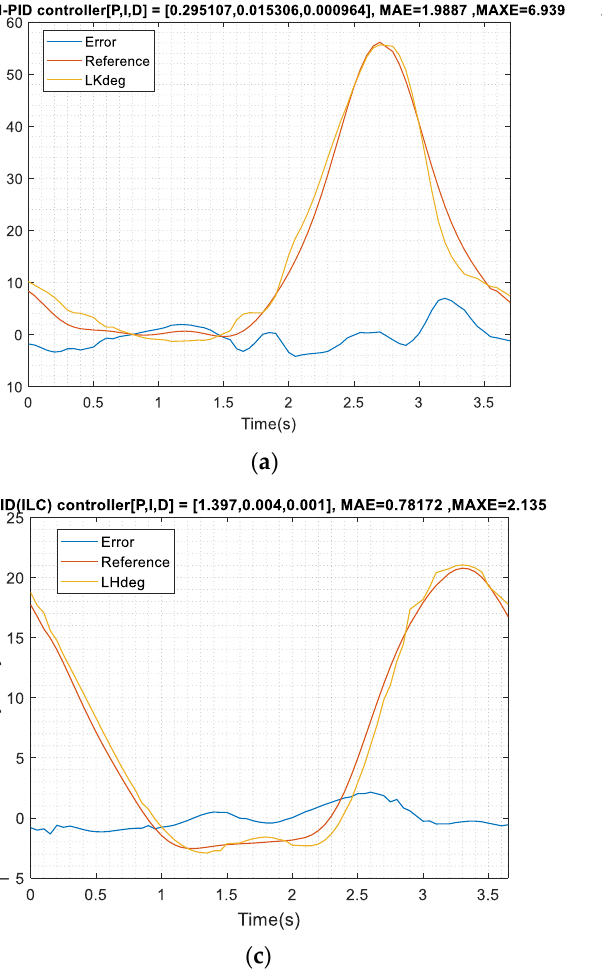
Figure 24. Subject P1 data. ( a ) Left knee tracking results; ( b ) right knee tracking results; ( c ) left hip tracking results; ( d ) right hip tracking results.